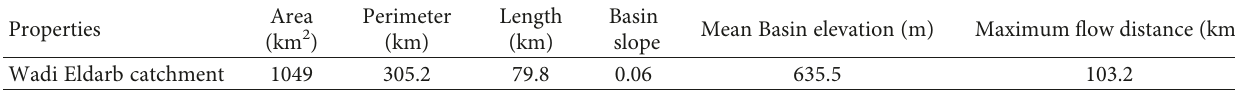
Table 1: Properties of Wadi Eldarb catchment.